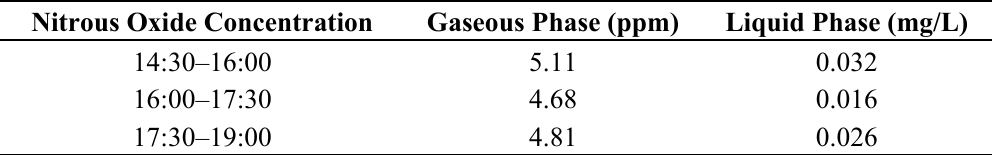
Table 3. Nitrous oxide concentration in the gaseous (instantaneous off-line sampling) and in the liquid